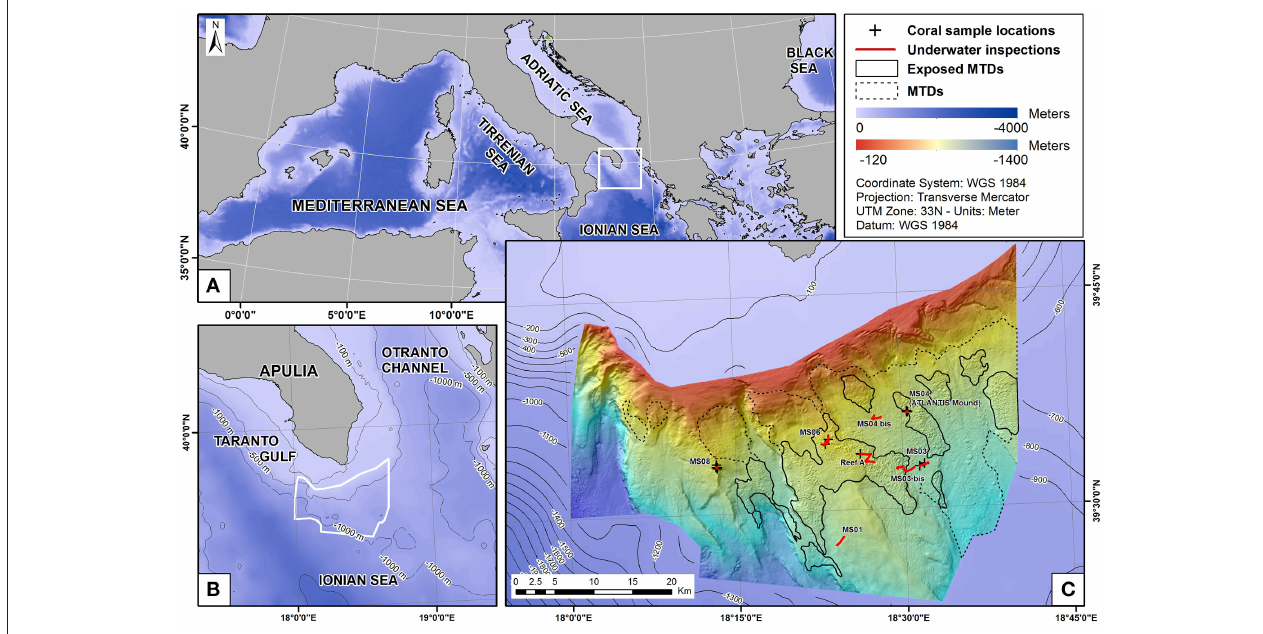
FIGURE 1 | (A,B) Location of the SML Province. (C) Bathymetric map of SML province, with the eight sites with cold-water corals. Underwater inspections (red lines) and coral sample locations (black crosses) are shown as well as the Mass Transport Deposit areas identified by Savini et al. (2016).